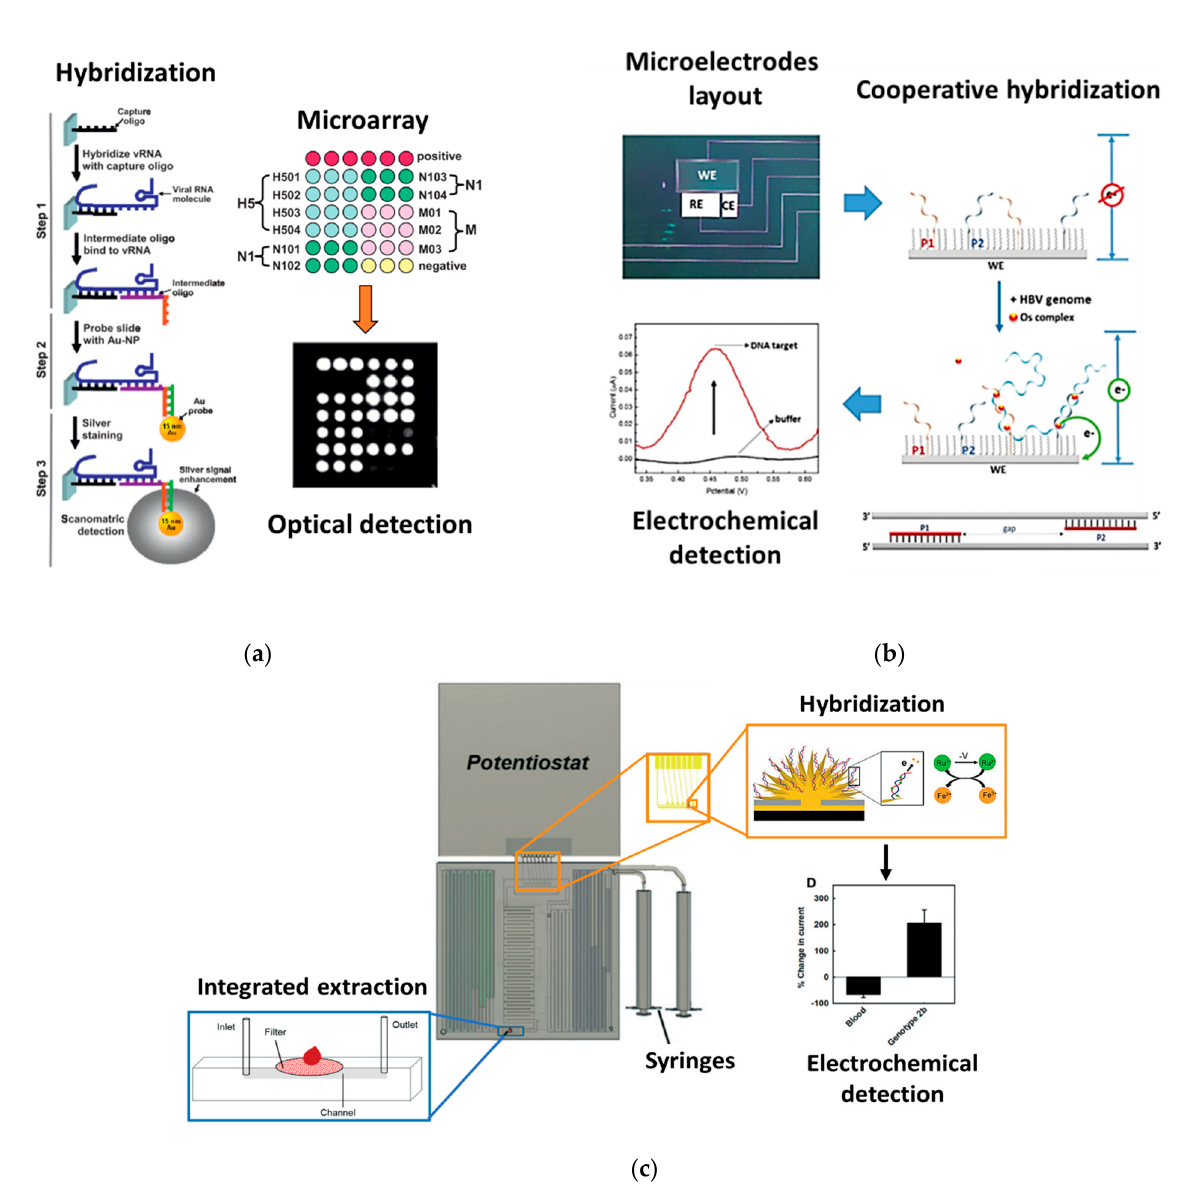
Figure 6. PCR-free virus detection strategies in genetic PoC systems. ( a ) Gold nanoparticle-based genomic microarray for the specific identification of avian influenza virus. Reproduced with permission from [71]. Creative Commons CC BY, Springer Nature. ( b ) Miniaturized electrochemical device for the PCR-free detection of HBV. Adapted from [72] ( c ) Fully integrated PoC system for PCR-free detection of HCV in blood. Adapted from [73] with permission from the Royal Society of Chemistry.